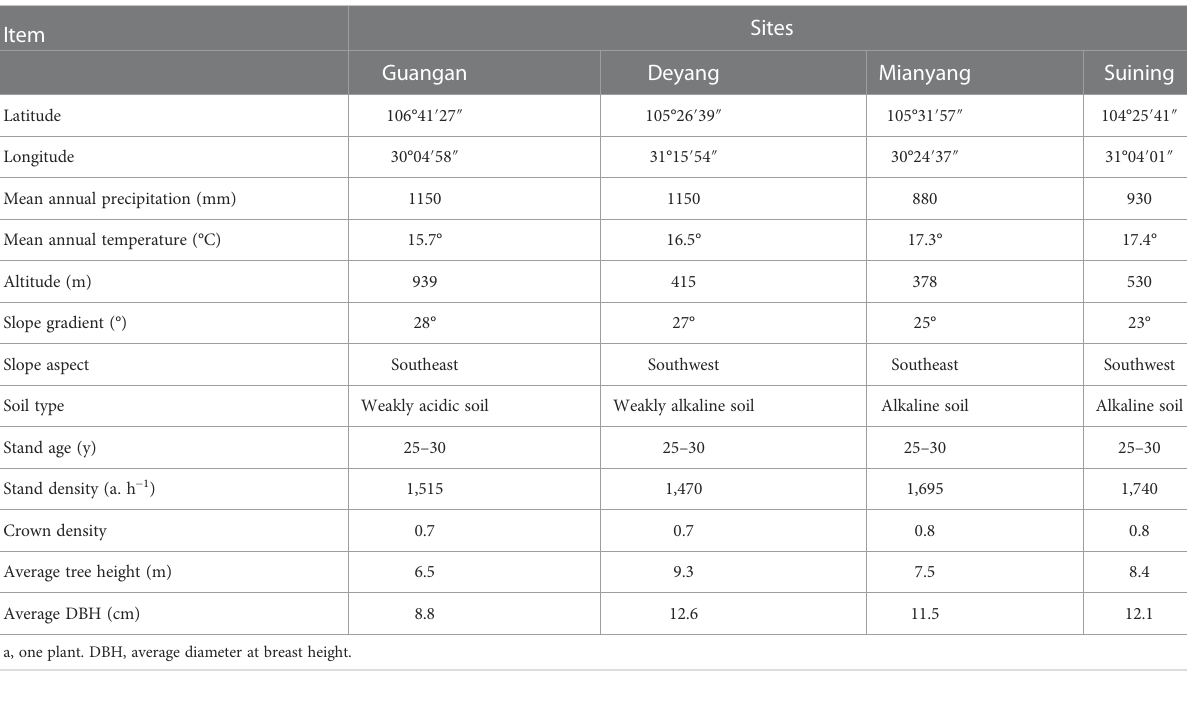
TABLE 1 Geographic information on different research